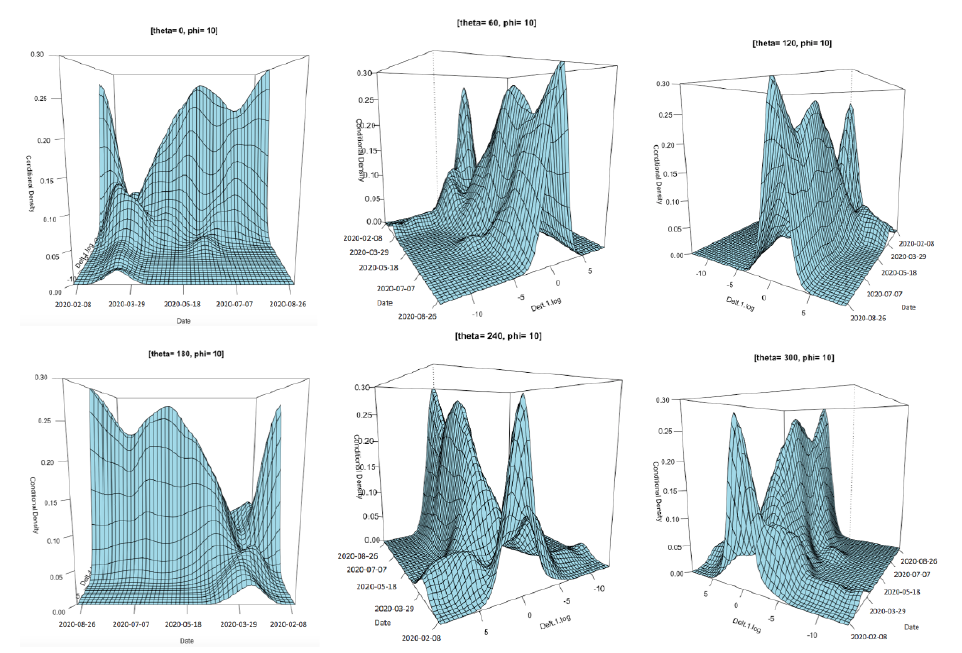
Figure 4. Density of NASDAQ: COVID